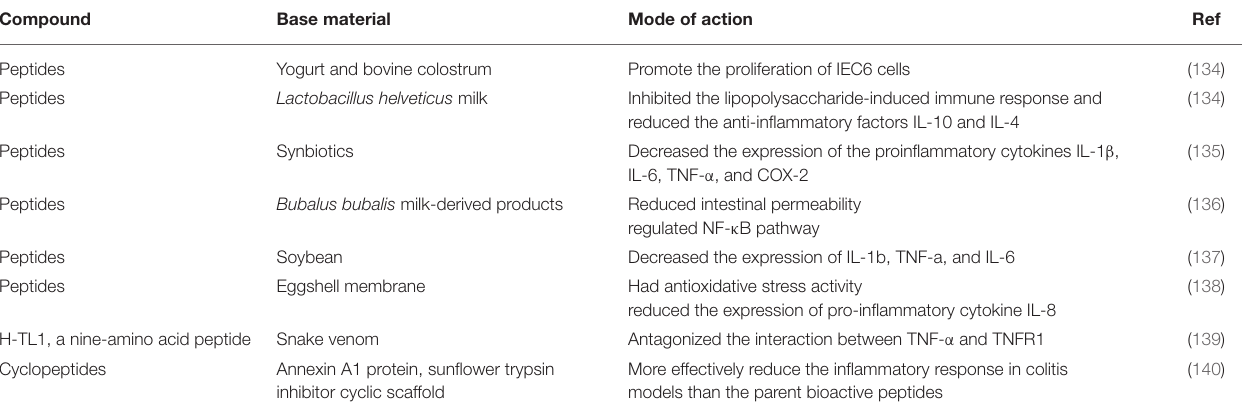
TABLE 4 | Effect of bioactive peptides on inflammatory bowel disease. Compound